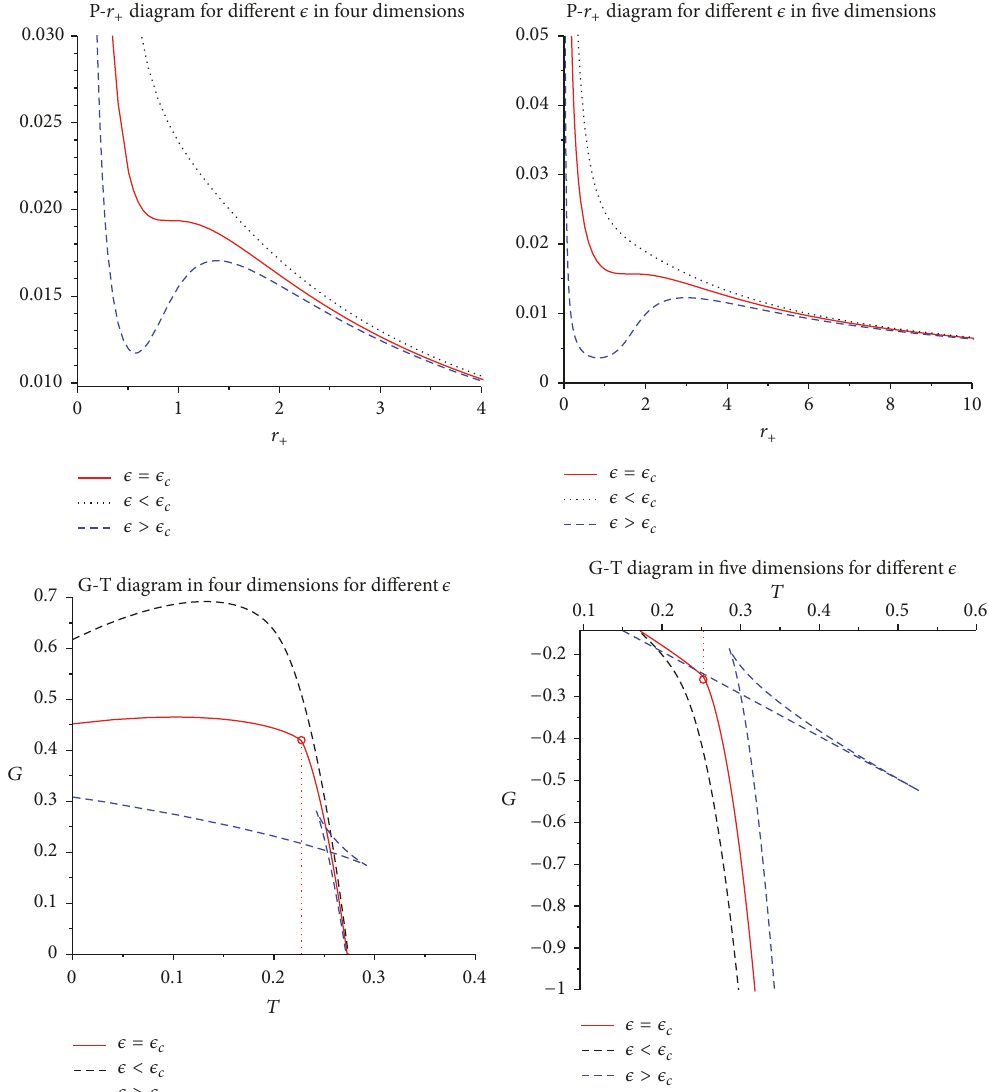
Figure 1: Curves of 𝑃−𝑟 + at the same temperature 𝑇 = 1/10 and 𝐺−𝑇 at the same pressure 𝑃 = 1/10 in four and five dimensions for different 𝜖 . When 𝜖 > 𝜖 𝑃 − 𝑟 𝑐 , there are the + oscillatory behavior and the classical “swallow tail” characterizing the small/large black holes phase transition. When 𝜖 = 𝜖 𝑐 , the second-order phase transition emerges and the dotted lines highlight the points where the second derivative of the Gibbs free energy 𝐺